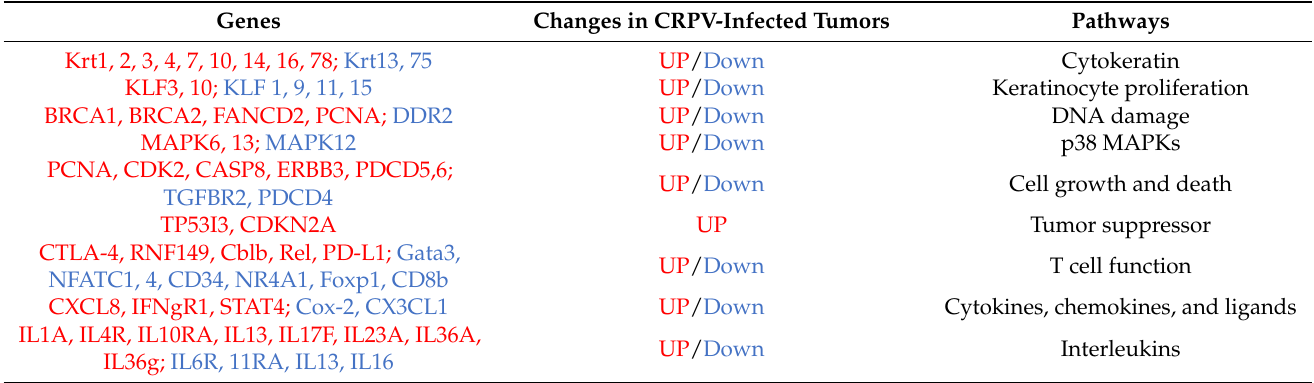
Table 2. Representative molecules related to cancers and T cell functions that are significantly changed in both the CRPV-induced tumor tissues AND cervical